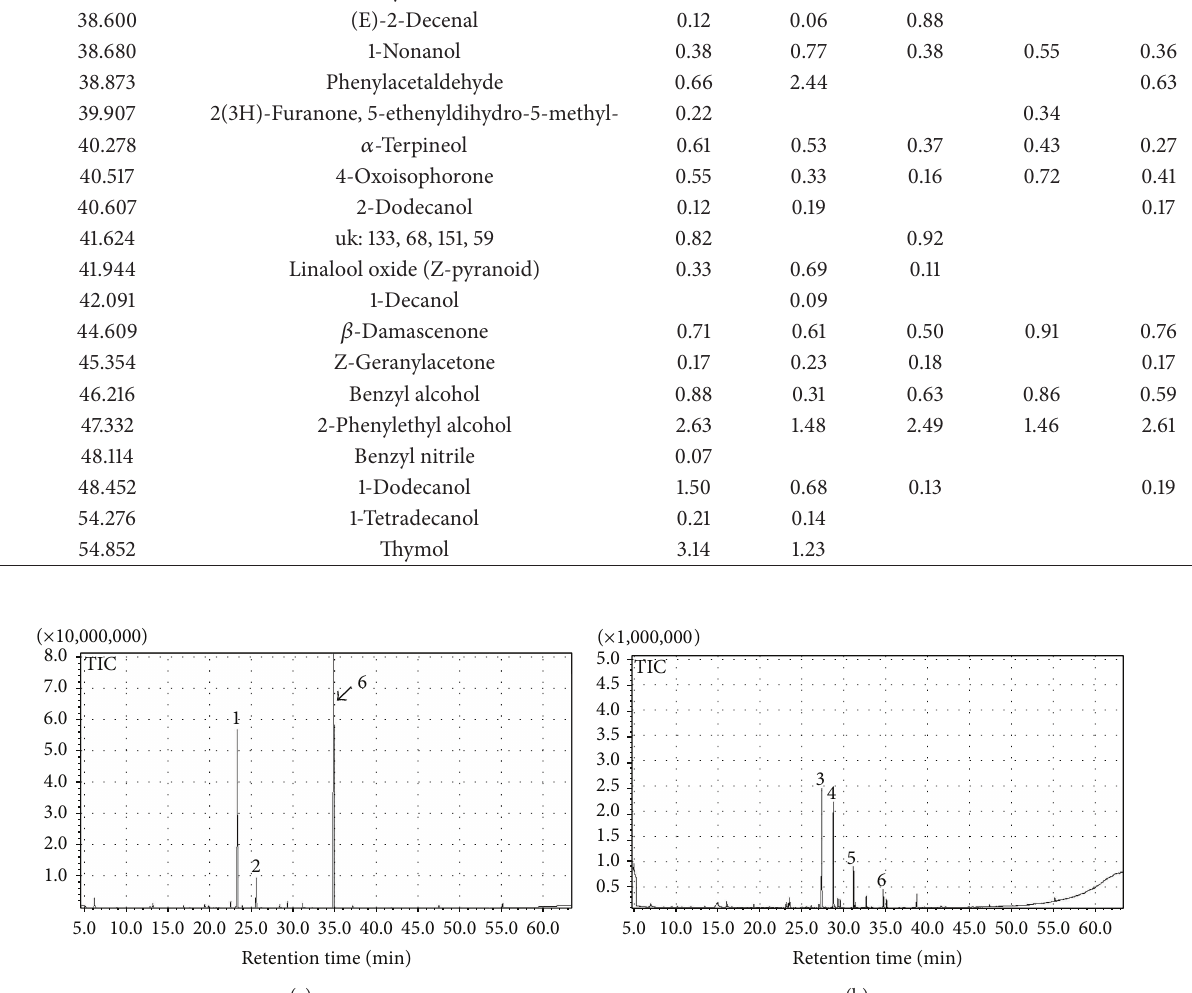
spectrometry. They found a complex flavonoid profile and suggested using flavonoid rhamnosides as floral